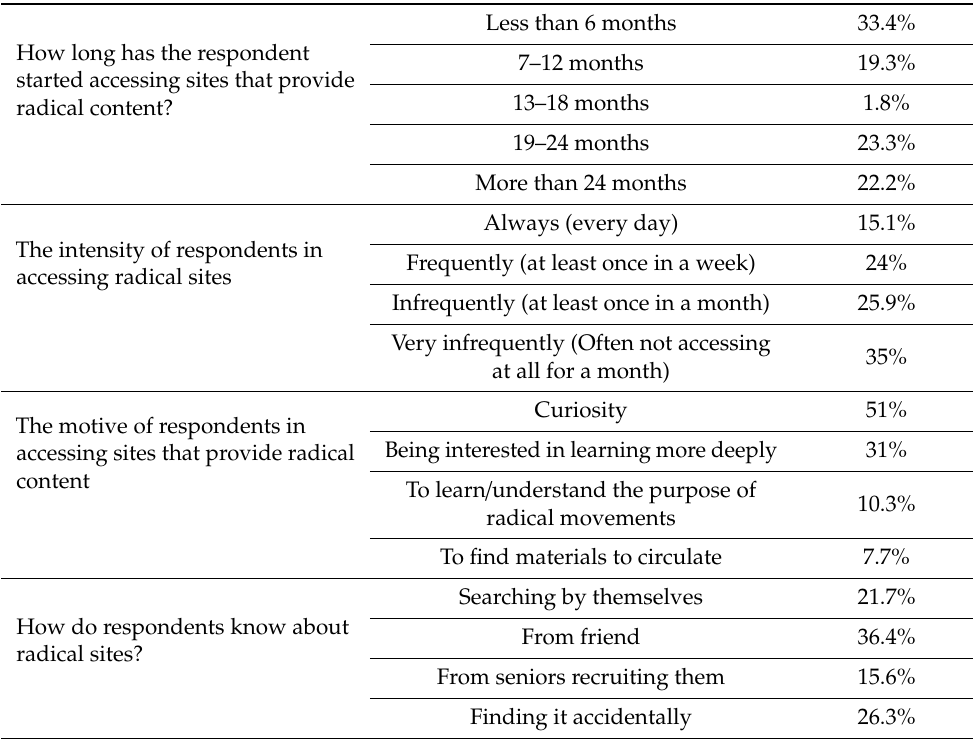
Table 3. Intensity and Motives of State University Students to Access Radical